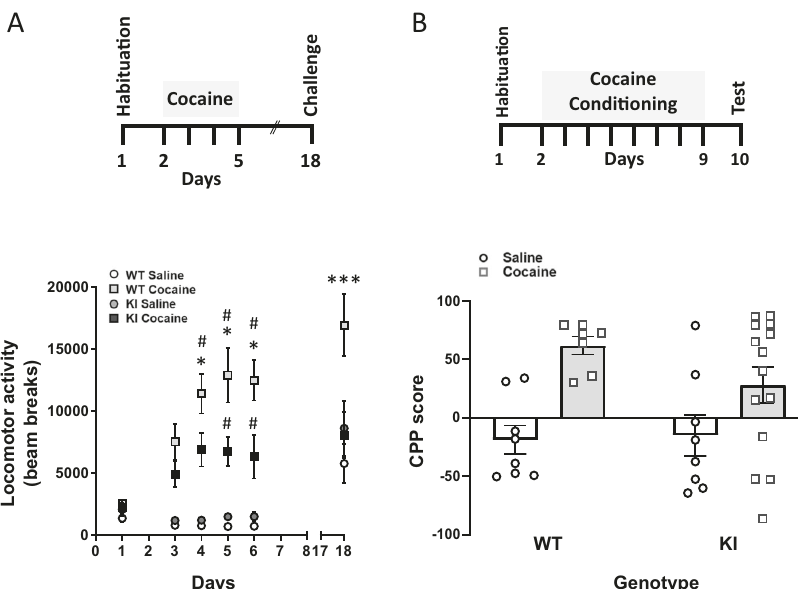
Fig. 2 Decreased cocaine-induced behaviours in eEF2K KI mice. For both psychomotor sensitization and condition place preference (CPP), mice were assigned to two groups according to genotype, and then randomly assigned either cocaine (15 mg/kg) or saline (1 ml/kg). A No difference was observed in the locomotor activity of either WT or KI mice following saline. Mixed effects model revealed a signi fi cant difference for genotype and treatment, [F(3, 29) = 18.82, P < 0.0001]. Sidak post hoc analysis identi fi ed that cocaine increased locomotor activity in both WT and KI mice compared with saline (# p < 0.001, days 4 – 6 for WT, days 5&6 for KI), but cocaine-exposed KI mice demonstrated reduced locomotor activity (* p < 0.05, days 4 – 6) compared with WT mice. In addition, KI show no expression of psychomotor sensitization following cocaine challenge (15 mg/kg, day 18, p > 0.9999, KI cocaine vs KI saline; *** p < 0.0001, WT cocaine vs WT saline; *** p = 0.0001, WT cocaine vs KI cocaine; N = 8 – 10). B All mice underwent a standard CPP paradigm for 2 weeks. CPP test was performed for all mice 1 day after the last conditioning session. Values are expressed as mean CPP score ± S.E.M. ( n = 7 – 14 per group), analysed by two-way repeated cocaine injections (four daily cocaine injections 15 mg/ kg, i.p.). A two-way ANOVA revealed a statistically signi fi cant